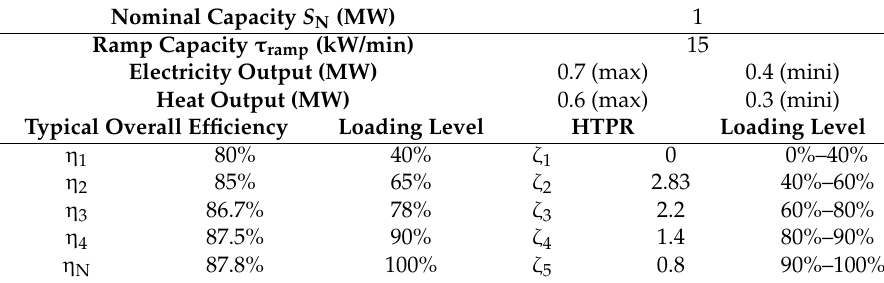
Table A1. Technical parameters of